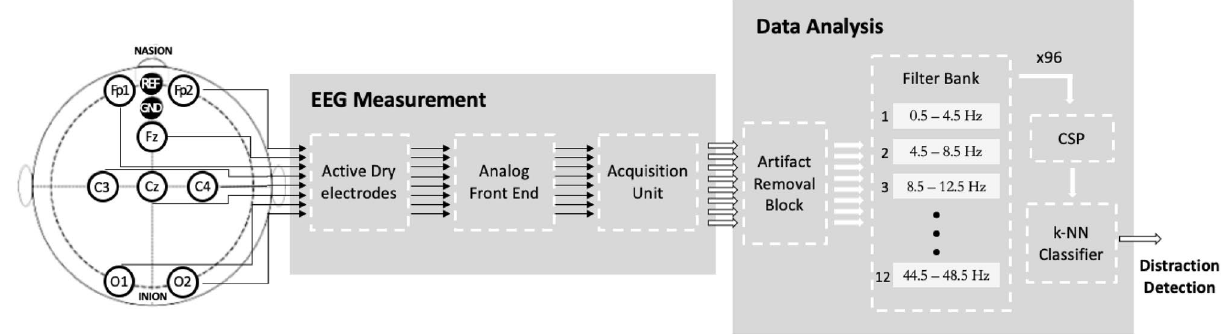
Figure 1. The proposed distraction-detection method (CSP: Common Spatial Pattern